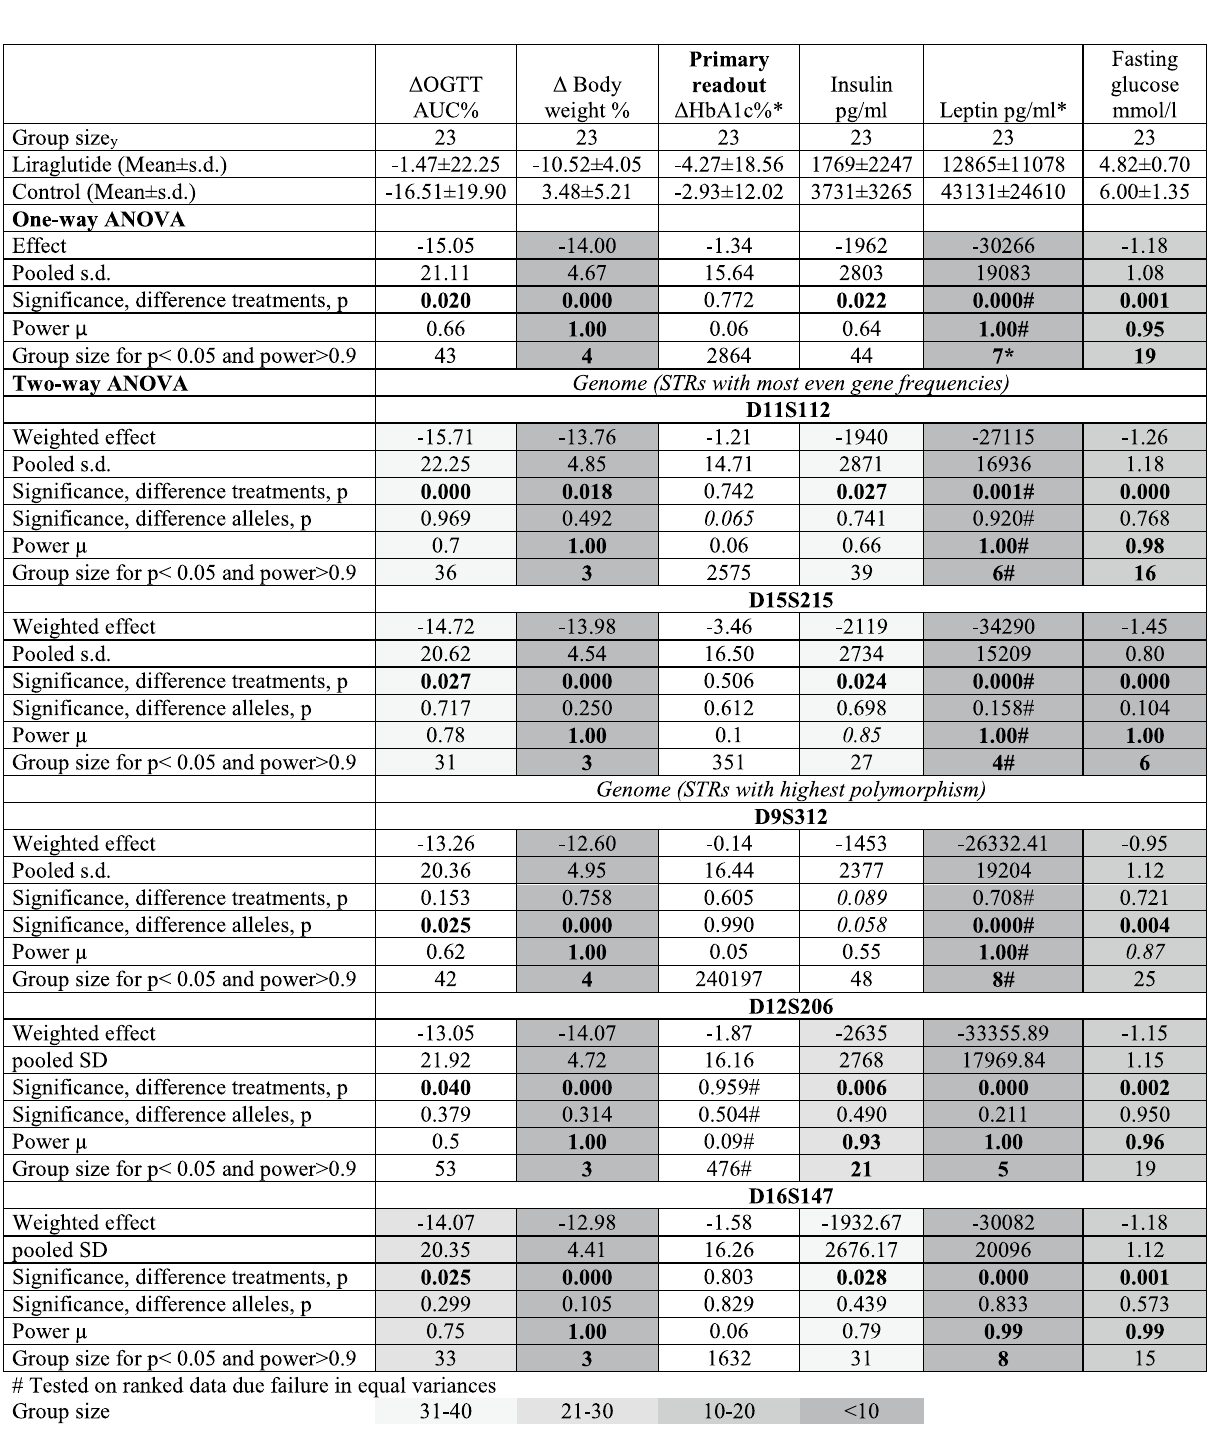
Table 4. Clinico-chemical parameters from testing the effect of liraglutide in diet-induced obese C57BL/6NRj mice and the subsequent evaluation by either one-way ANOVA or two-way ANOVA including either alleles with the most even gene frequencies or alleles with the highest polymorphism as a factor. Group sizes are written in bold if they are lower than the actual efficient group size. p < 0.05 are written in bold, p = 0.05 -0.010 are written in italics. Power is written in bold if > 0.90 and in italics if 0.80 - 0.90. Significant values are in bold. Italics: borderline significance (p <